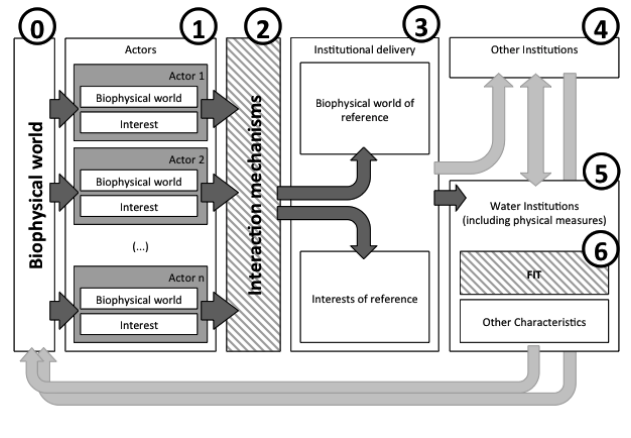
Fig. 1 . Analytical framework. The boxes with the oblique pattern represent the objects of our research question. Links that are not explored herewith are instead grayed